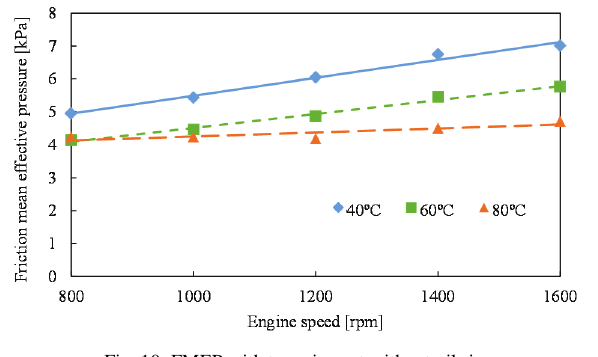
Fig. 10. FMEP with two-ring set without oil ring